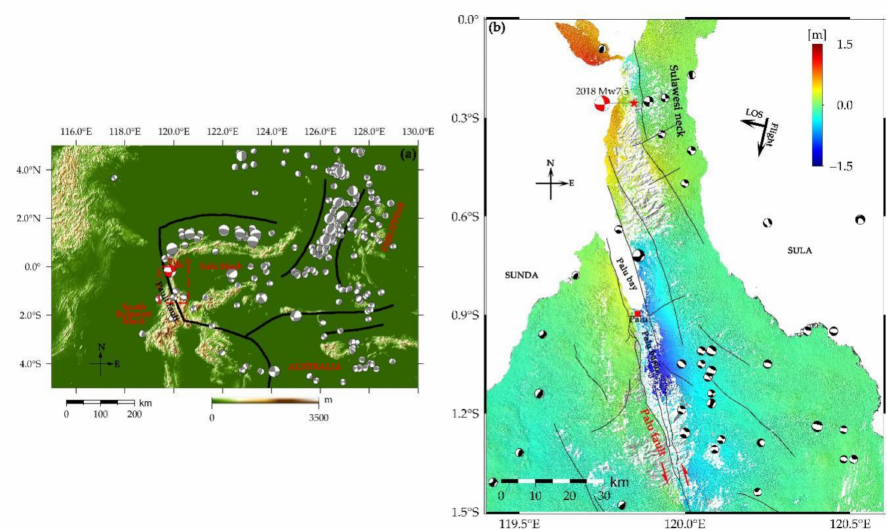
Figure 1. Tectonic setting and surface displacements of the 2018 Mw7.5 Palu earthquake. ( a ) Black lines indicate the geological traces of active faults. Red dotted rectangle corresponds to the study area ( b ). ( b ) The coseismic line-of-sight (LOS) displacement was reconstructed using pre- and post-seismic Advanced Land Observing Satellite (ALOS)-2 descending synthetic aperture radar (SAR) imagery. The red star and red beach ball indicate the epicenter and focal mechanism from the United States Geological Survey (USGS), respectively. Black lines indicate the geological traces of active faults. Black and gray beach balls indicate the focal mechanisms of historic